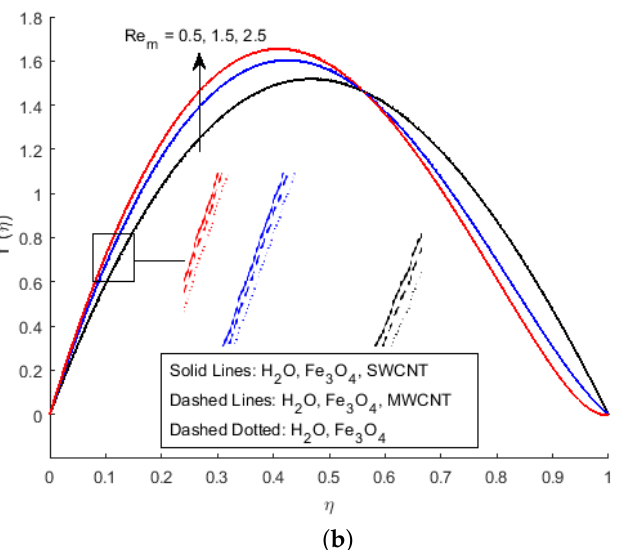
Figure 3. Effect of f (cid:48) ( η ) for ( a ) Ha , ( b ) Re m and fixed values of S = 2.5, Pr = 6.2, Ec = 0.5, δ =